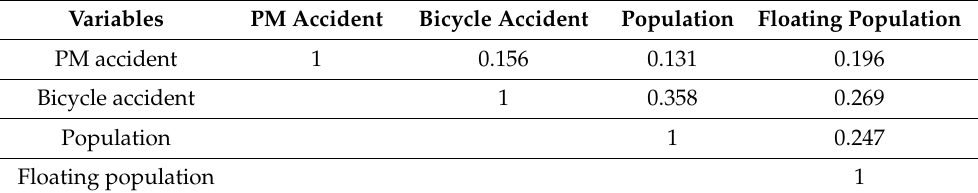
Table 3. Pearson correlation coefficients between accidents and population.